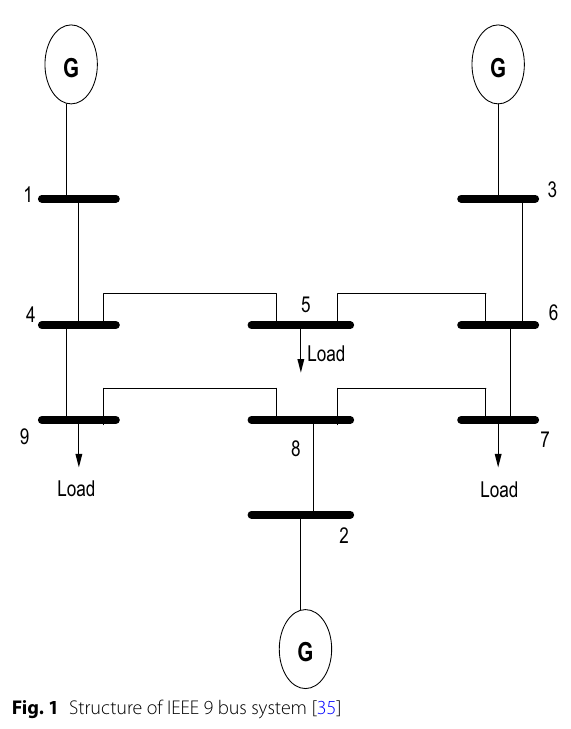
Fig. 1 Structure of IEEE 9 bus system [35]